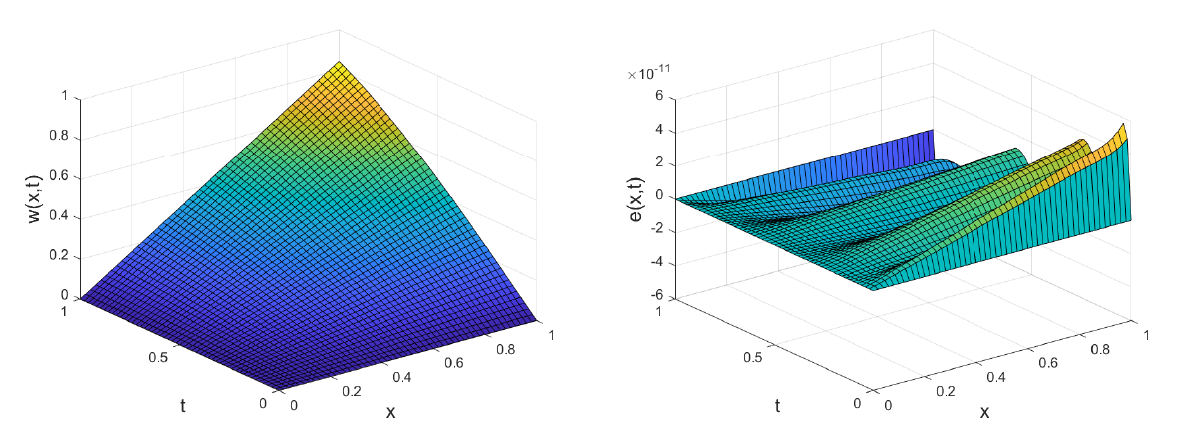
Figure 5. Plot of the approximate solution and absolute value of the error for Example